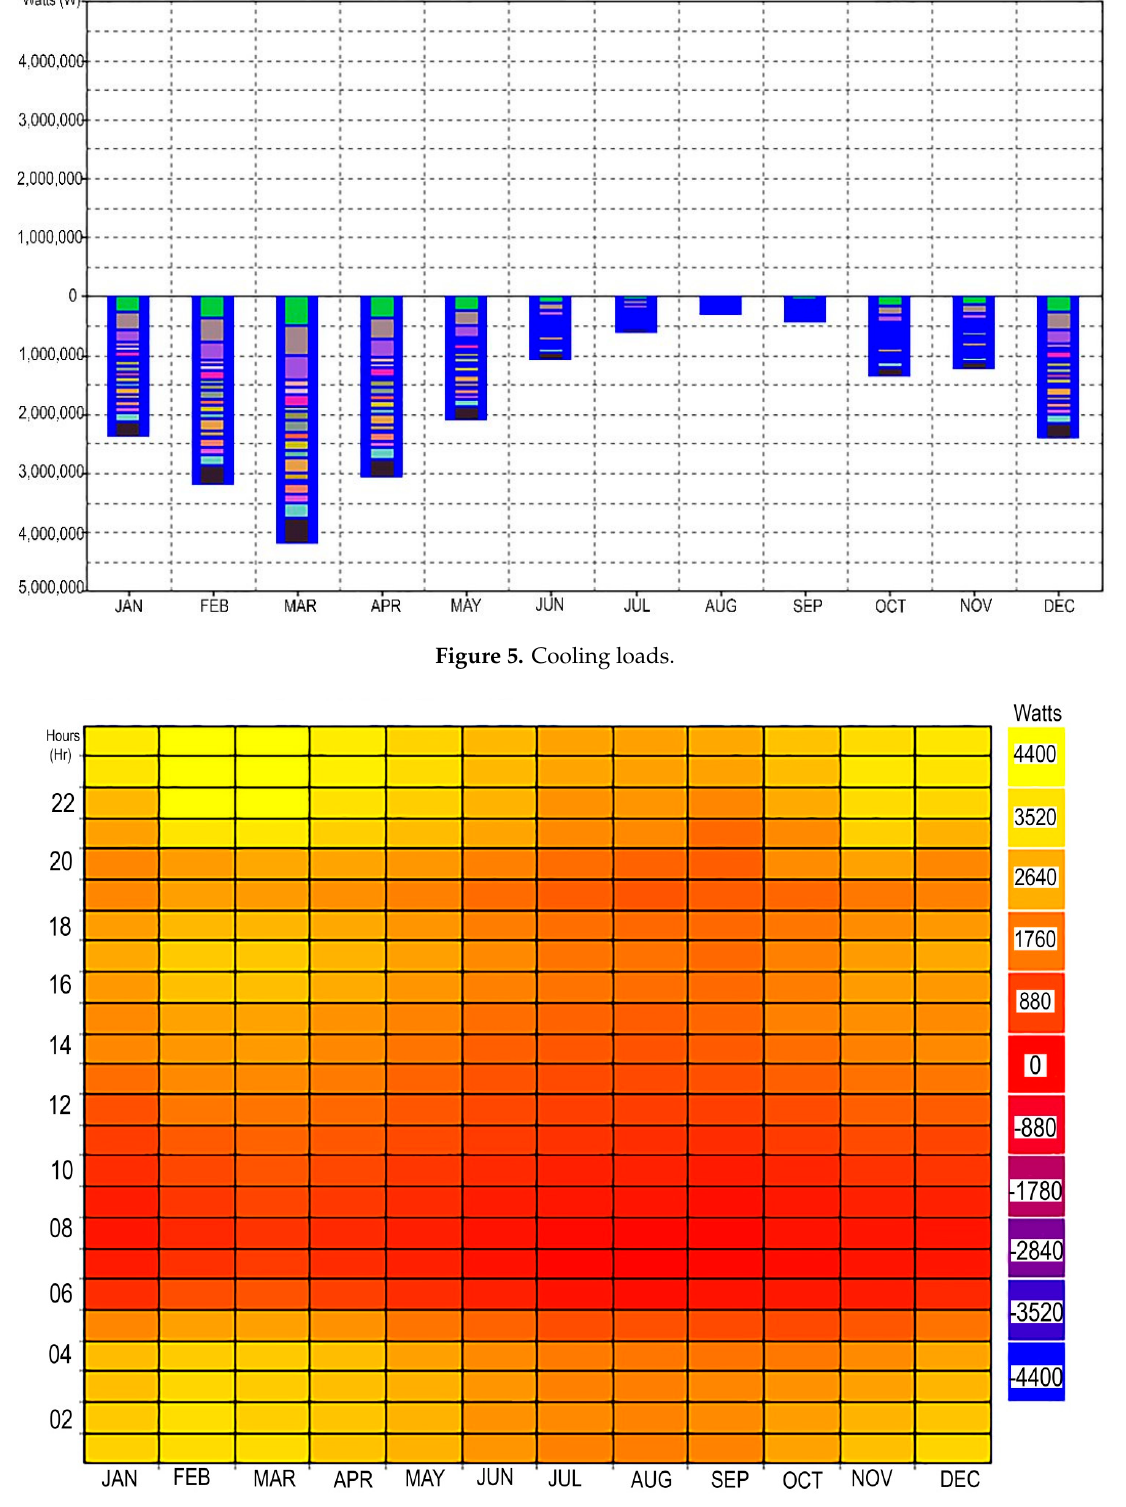
Figure 6. Effect of thermal mass on heat gain/loss in rammed earth. Figure 6. E ff ect of thermal mass on heat gain / loss in rammed